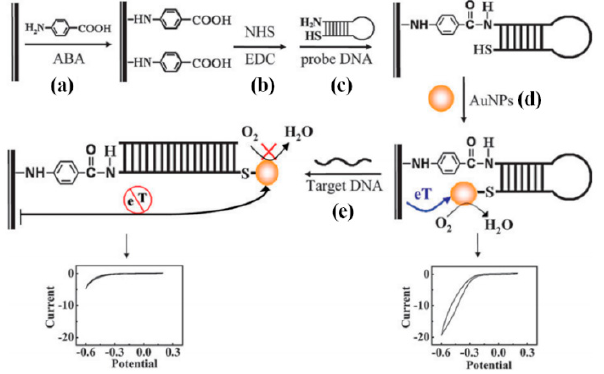
Figure 13. A scheme for the detection of HCV by using GNPs labeled conformation-switched hairpin DNA probe and electrocatalytic signal amplification (Reproduced with permission from [101]).